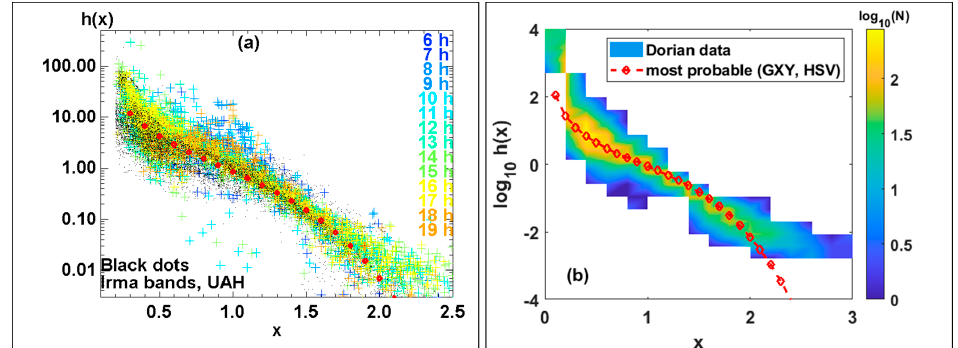
Figure 3. ( a ) h(x) versus x from 06:00 to 20:00 UTC. Each color represents each hour. Black points represent h(x) derived from 3 min DSD data in outer bands of hurricane Irma at HSV site. Red diamonds represent same most probable h(x) versus x from composite DSDs from GXY and HSV as in Figure 2. ( b ) Color intensity plot of h(x) for whole Dorian rainband event and most probable or composite h(x) curve from GXY and HSV data (same as red diamonds in Figure 3a).